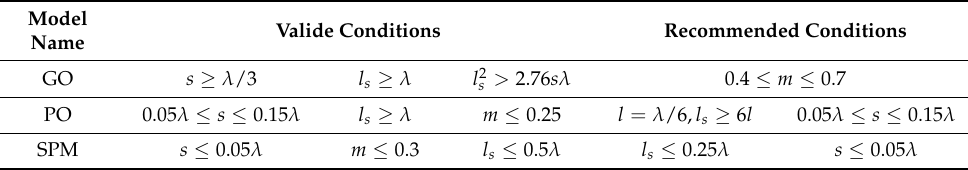
Table 1. Application range of the GO model, PO model, and SPM